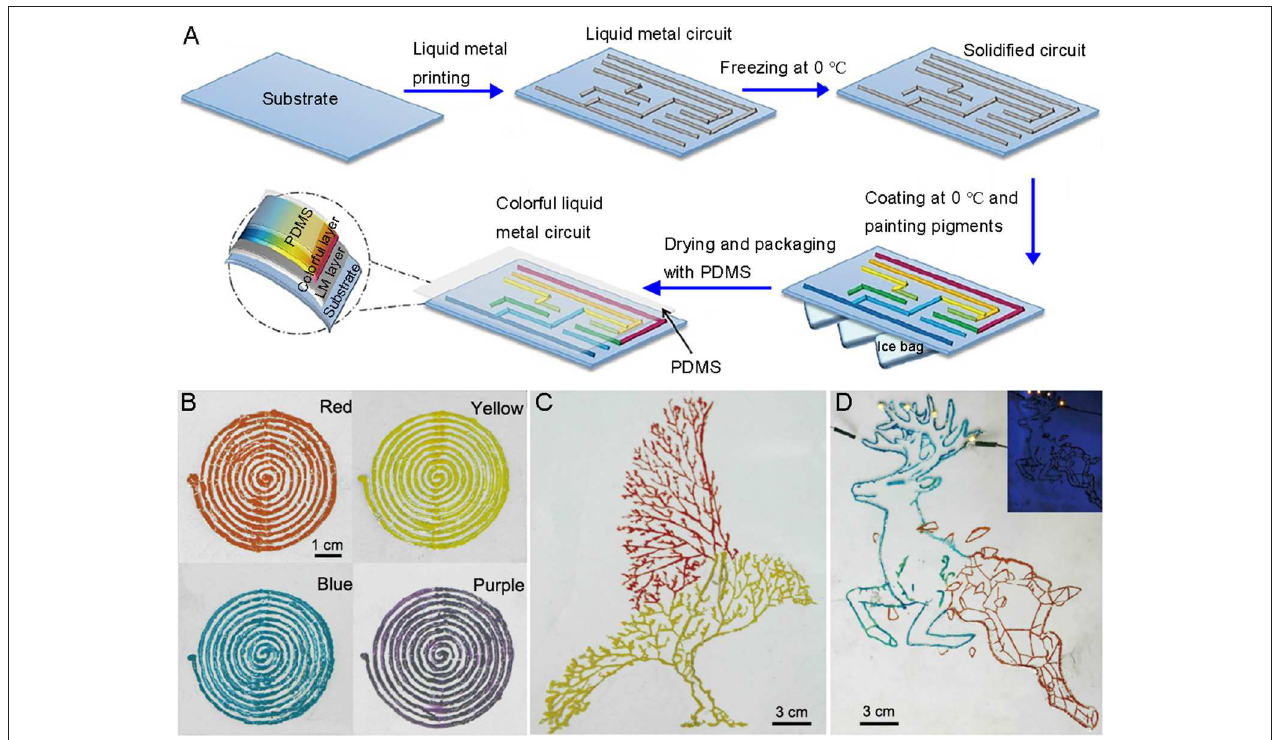
FIGURE 12 | Schematic diagram of colorful liquid metal circuit fabrication process (A) , and Ga-based liquid metal inductance coil with different colors (B) , and liquid metal color image of eagle pattern (C) , and liquid metal color image of deer pattern, top right inset is the photo of the pattern after electrifying (D) . Reproduced with permissions from Liang and Liu (2018). Copyright 2018, Science China Press and Springer